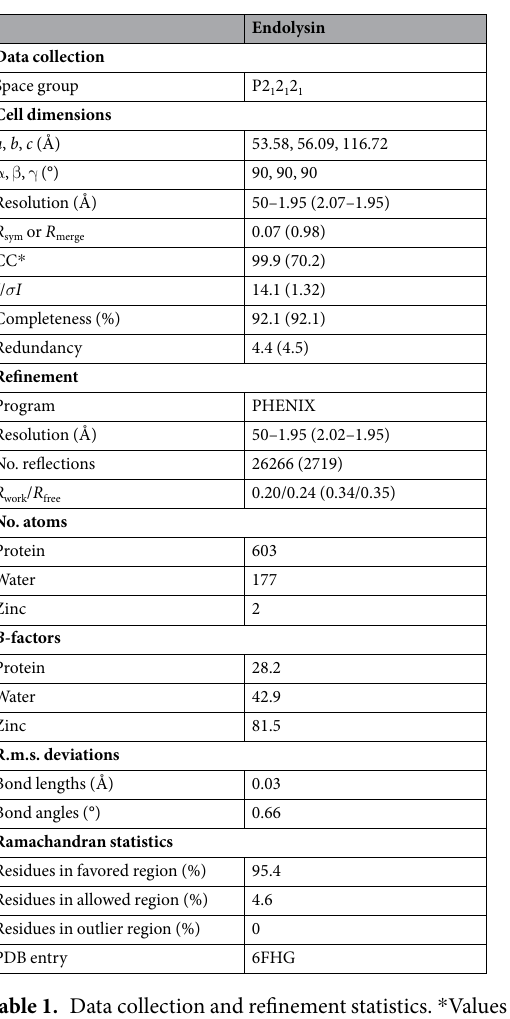
Table 1. Data collection and refinement statistics. * Values in parentheses are for the highest-resolution shell.